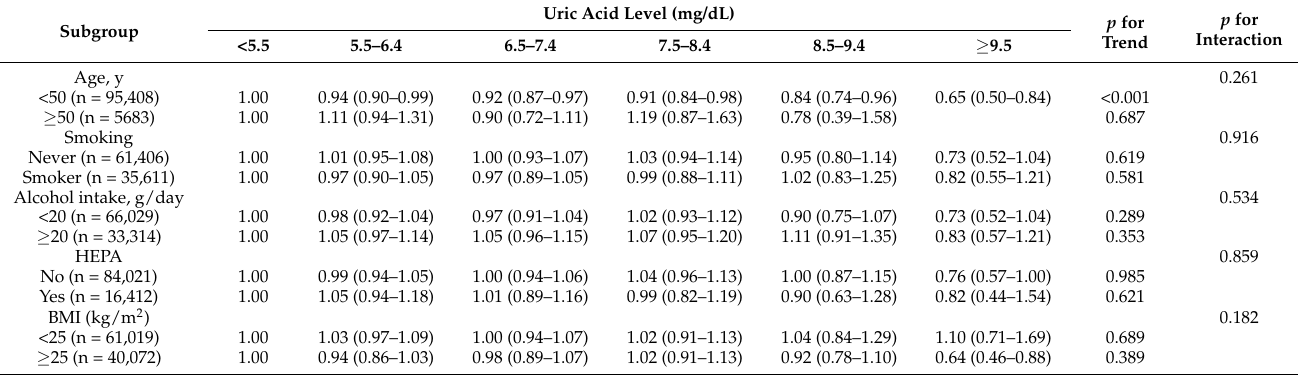
Table 3. Hazard ratios 1 (95% CI) of LUTS (>8) by the pre-set subgroups.